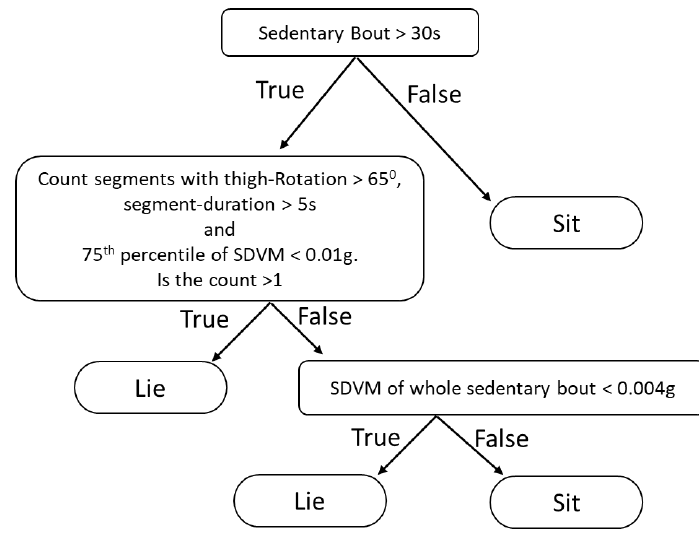
Figure 3. Decision tree of Algorithm B.